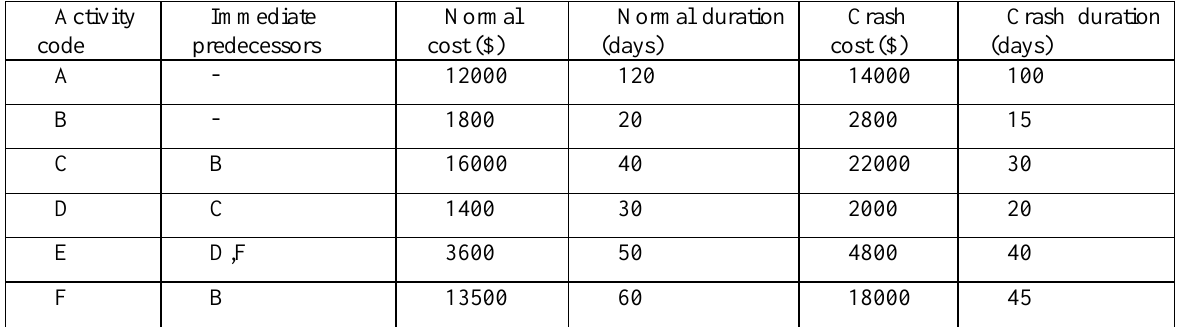
Table 2. List of normal and crash cost-time